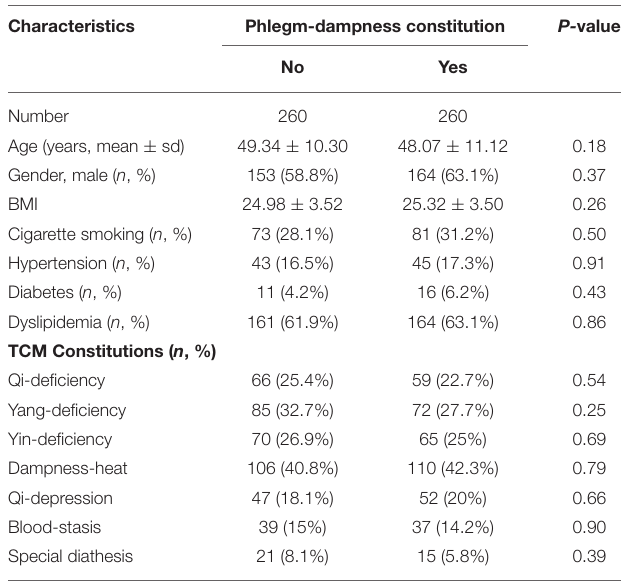
Characteristics